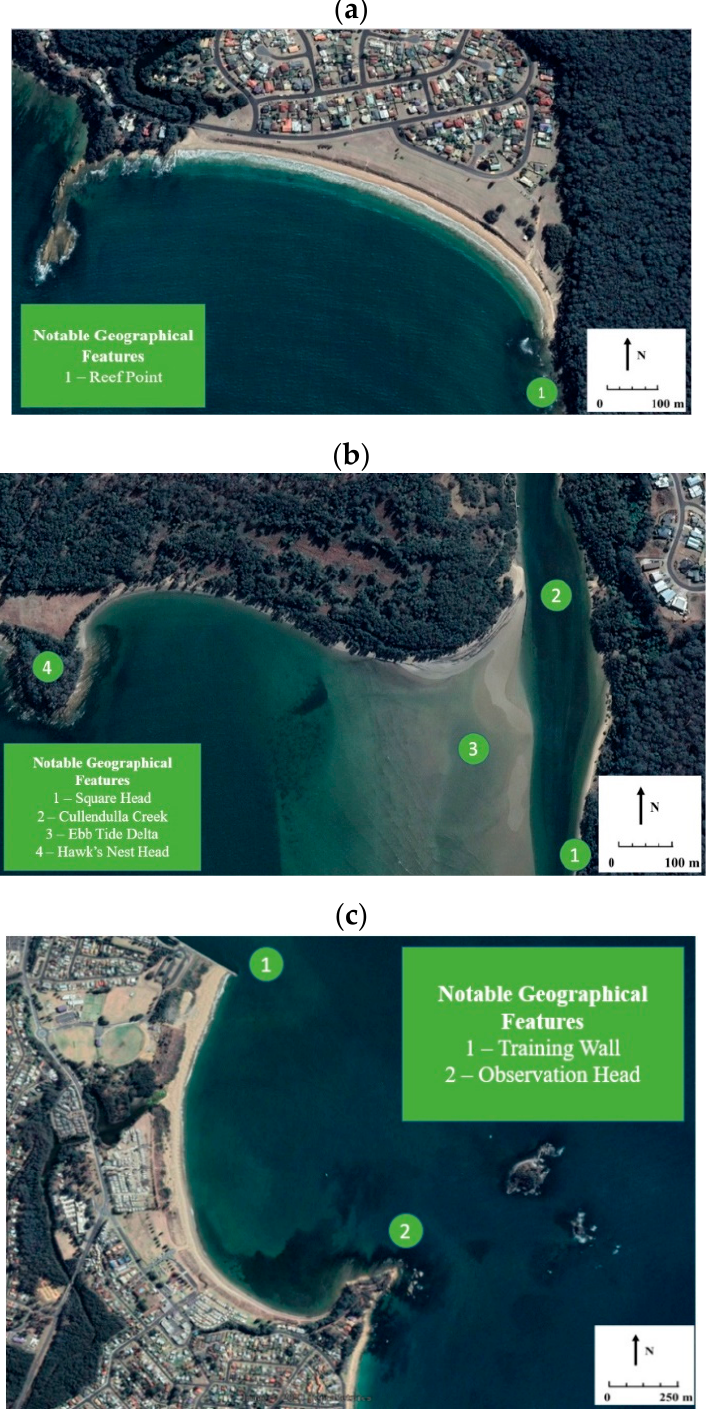
Figure 2. ( a ) Maloney’s Beach: 35.7096 ◦ S, 150.2461 ◦ E; ( b ) Cullendulla Beach” 35.7007 ◦ S, 150.2021 ◦ E; and ( c ) Corrigans Beach: 35.7309 ◦ S, 150.2005 ◦ E (source: Google Earth